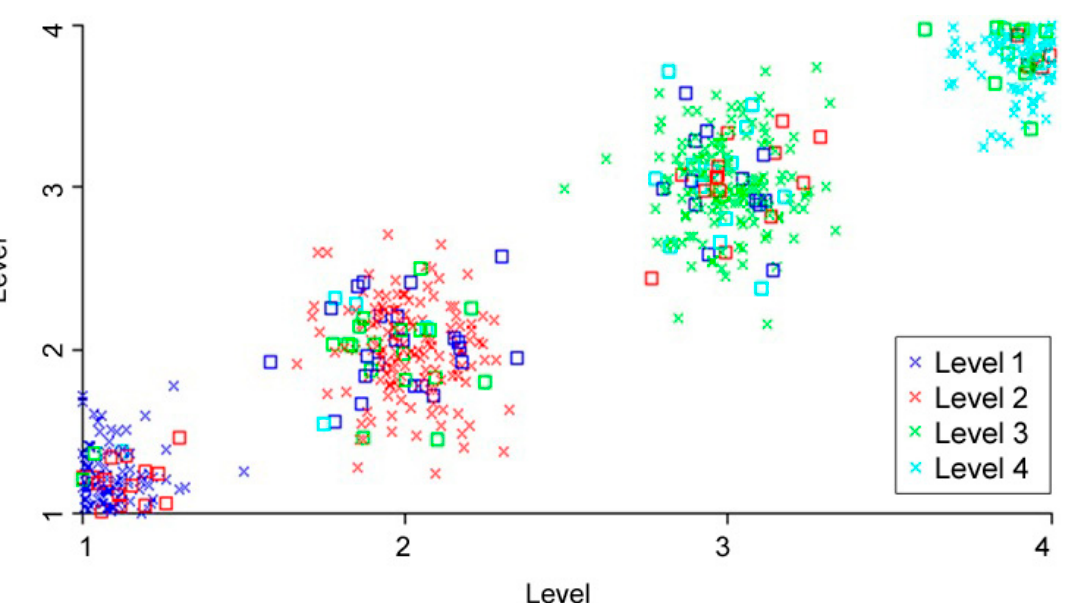
Figure 6. Faulty distribution chart—Line-fed motor.